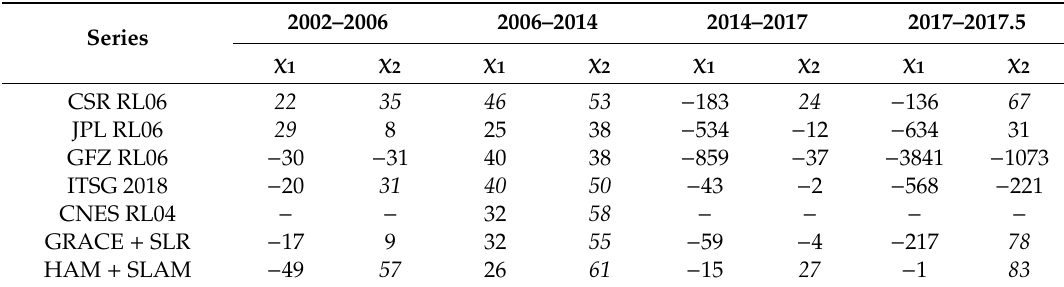
Table 4. Percentage of variance in GAO explained by variance of GSMAM, GRACE + SLR, and HAM + SLAM for four considered time periods. Before computing the values, linear trends were removed from the series. Note that CNES RL04 was included only for the period 2006–2014. The highest values of relative explained variances are